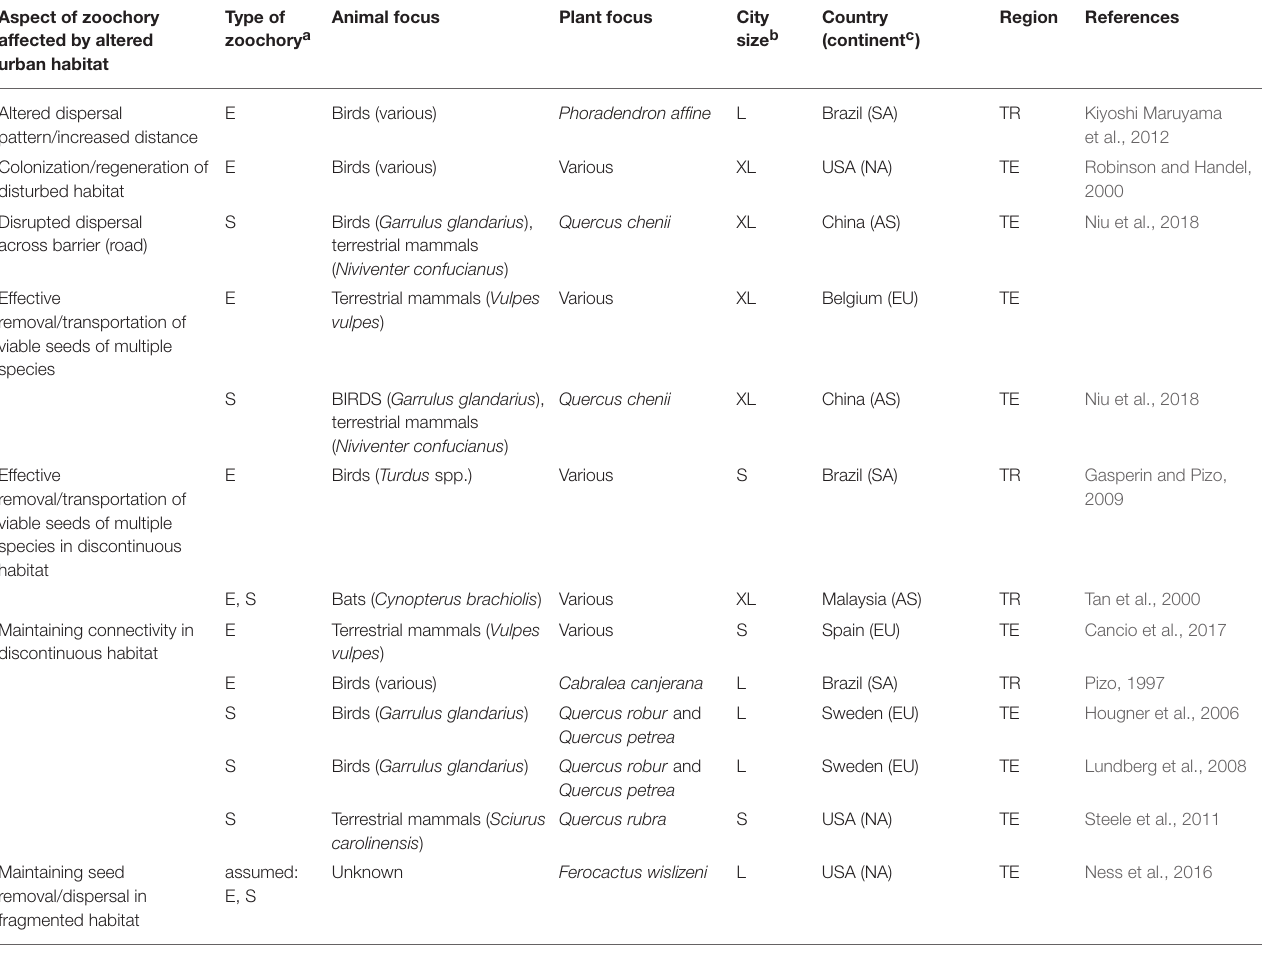
TABLE 1 | Effects of habitat complexity on urban zoochory and vice